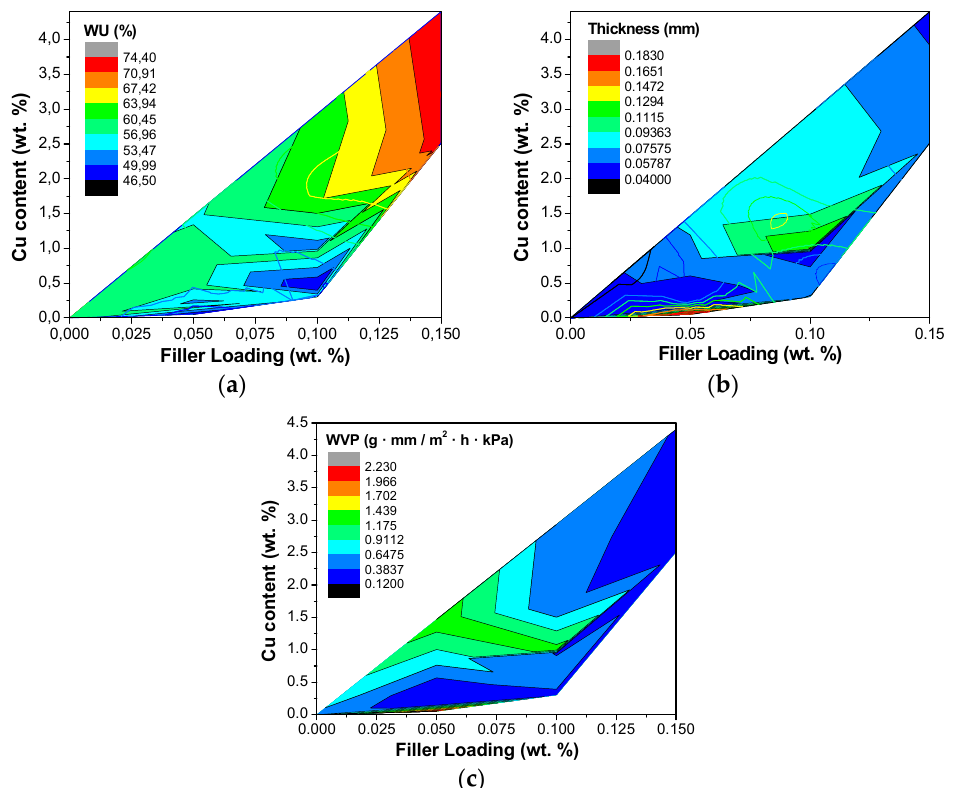
Figure 7. Contour plots of the regression models obtained for parameters WU ( a ); thickness ( b ) and WVP ( c ).